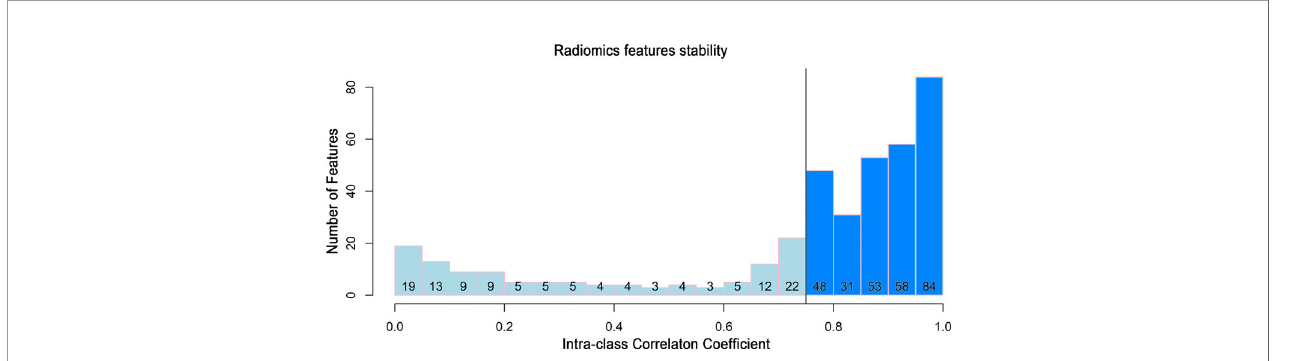
FIGURE 3 | Histogram of the intraclass correlation coef fi cient. Histogram of the ICC for the radiomics features between two readers. ICC, intraclass correlation coef fi cient.